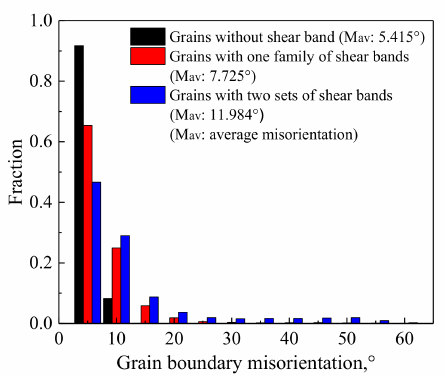
Figure 14. Misorientation distribution of grain boundaries in the interiors of the original deformed grains having different shear hand families and density (not including original high-angle grain boundaries) after deformation at Z = 3.34 × 10 30 and strain of